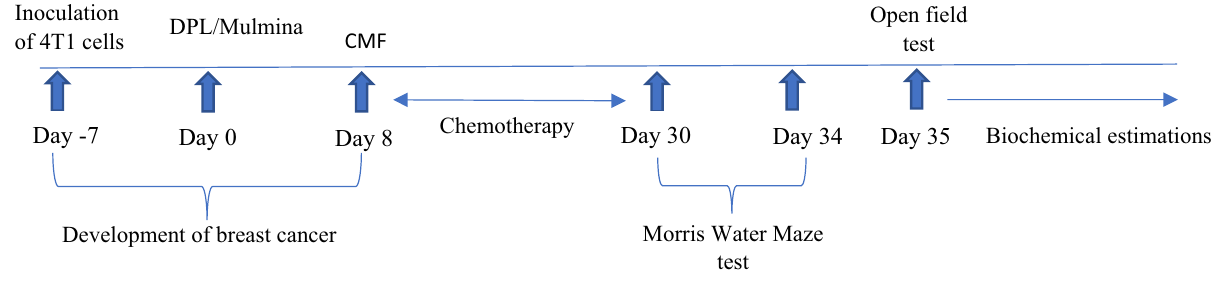
Figure 1. Study design.